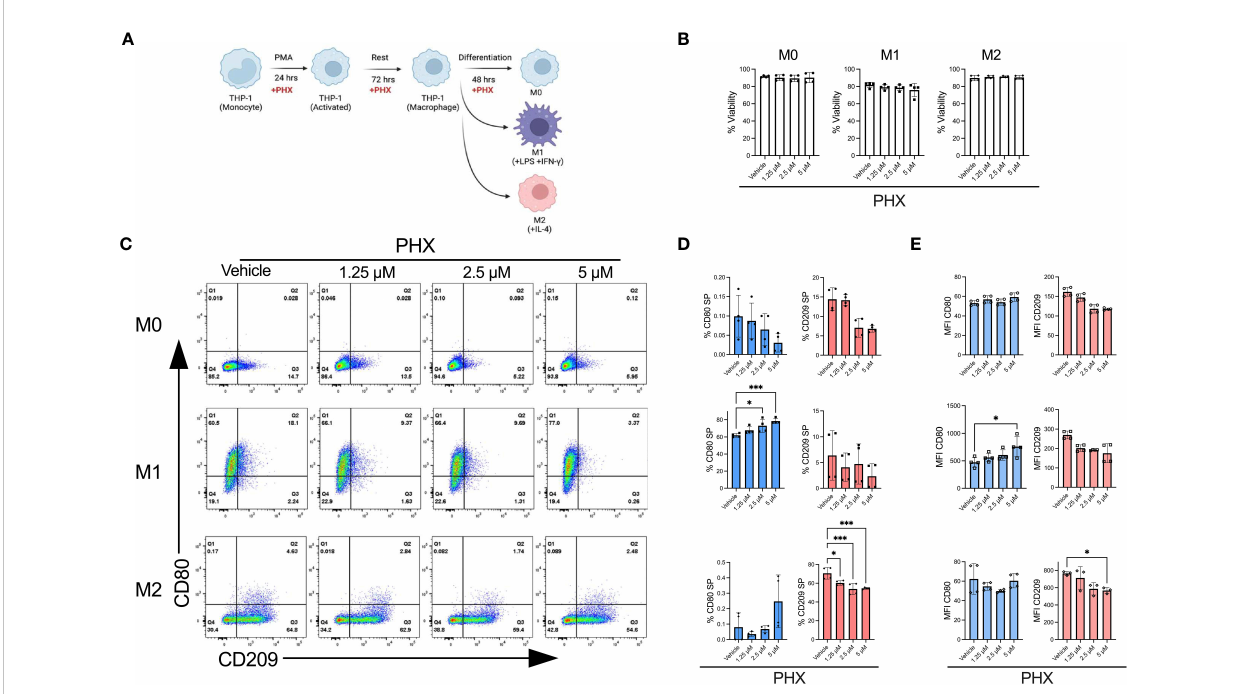
FIGURE 1 Perhexiline (PHX) promotes THP-1 monocyte differentiation into M1 macrophages. (A) Schematic diagram showing PHX addition during PMA mediated THP-1 M0, M1 and M2 differentiation. (B) Viability of THP-1 differentiated macrophages with or without PHX treatment. (C) Flow cytometry plots showing the expression of CD80 and CD209 for THP-1 differentiated macrophages with or without PHX treatment. (D) Quanti fi cation of % CD80 (blue) single positive (SP, Q1 gate) and % CD209 (pink) SP (Q3 gate) with or without PHX treatment and (E) MFI values of CD80 and CD209 of THP-1 differentiated macrophages (M0 top, M1 middle, M2 bottom). Data are pooled from two independent experiments with duplicates (n=4) and shown as mean ± SD. One-way ANOVA with Dunnett's multiple comparisons test was performed for the analysis * p ≤ 0.05; *** p ≤